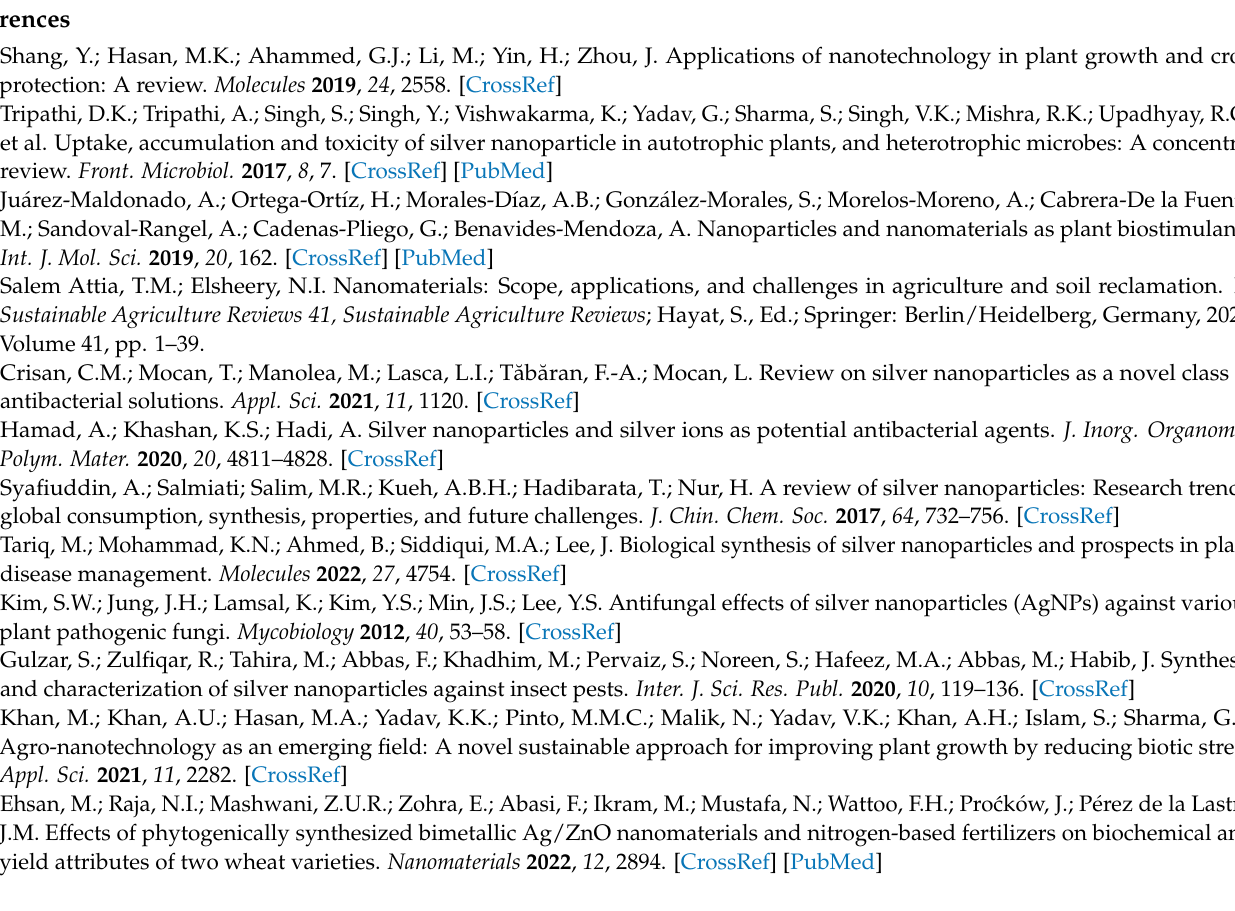
These seedlings were developed for 3 days (in double-distilled water (DDW)) from grains imbibed for 24 h in DDW or water solutions of myo -inositol (MIN), D - chiro -inositol (DCI) or D -pinitol (PIN) at concentrations of 100 mM each. Values are means of three replicates. The same superscript letters by the values indicate no significant ( p < 0.05) differences after ANOVA test and Tukey’s post hoc corrections. Figure S1. The effects of D -pinitol (PIN, 50 mM), glutathione (GSH, 12.5 mg/L), (Bio)Ag NPs (at 40 mg/L) and their mixtures on the concentrations of sucrose, glucose (A,B), maltose and maltotriose (C,D) in the endosperm of 3 day old seedlings of wheat ( Triticum aestivum L. cv. Collada) developed from non-primed (A,C) and primed grains (B,D). Values are means ( n = 3) + SD. Bars with the same letters (a–e) were not significantly ( p < 0.05) different after ANOVA test and Tukey’s post hoc